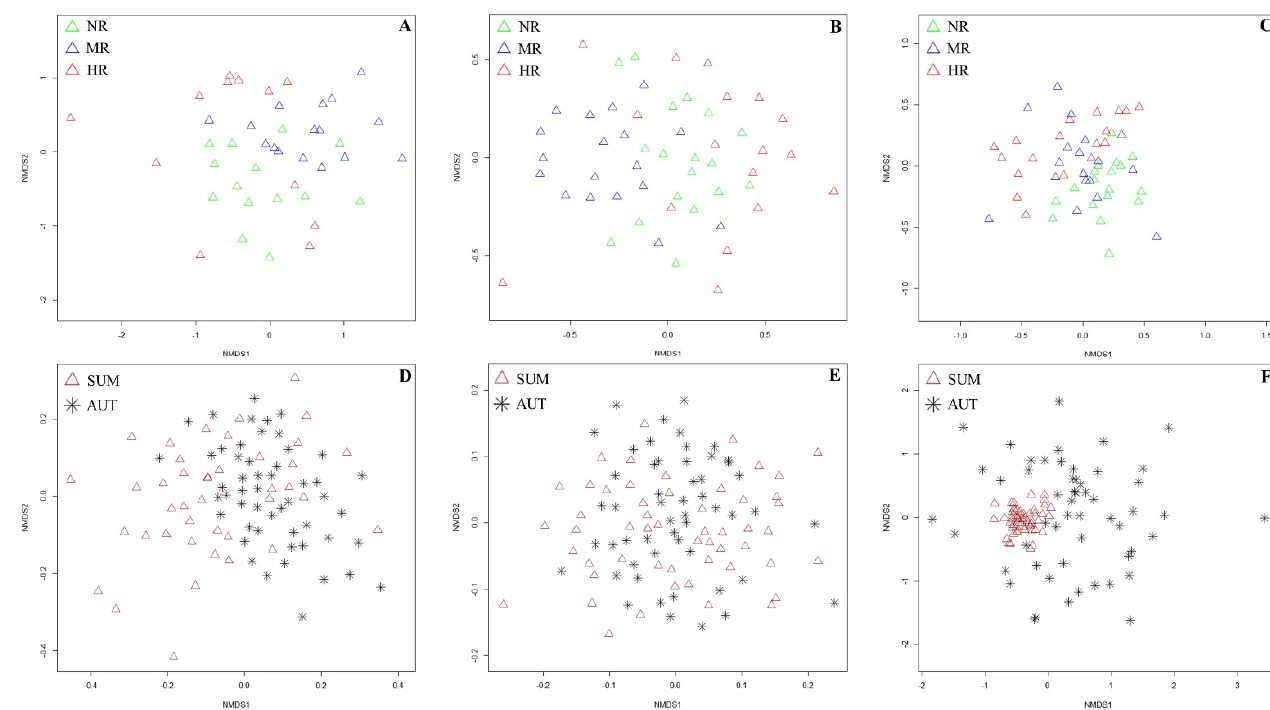
Figure 4. Non-metric multidimensional scaling (NMDS) based on Bray–Curtis distances visualizing the distributions of soil fauna community of different revetment types and different seasons: ( A ) dis- tribution of three revetment types for soil macrofauna in summer; ( B ) distribution of three revetment types for microarthropods in summer; ( C ) distribution of three revetment types for the hygrophilous mesofauna in summer; ( D ) distribution of two seasons for soil macrofauna; ( E ) distribution of two seasons for microarthropods; and ( F ) distribution of two seasons for the hygrophilous